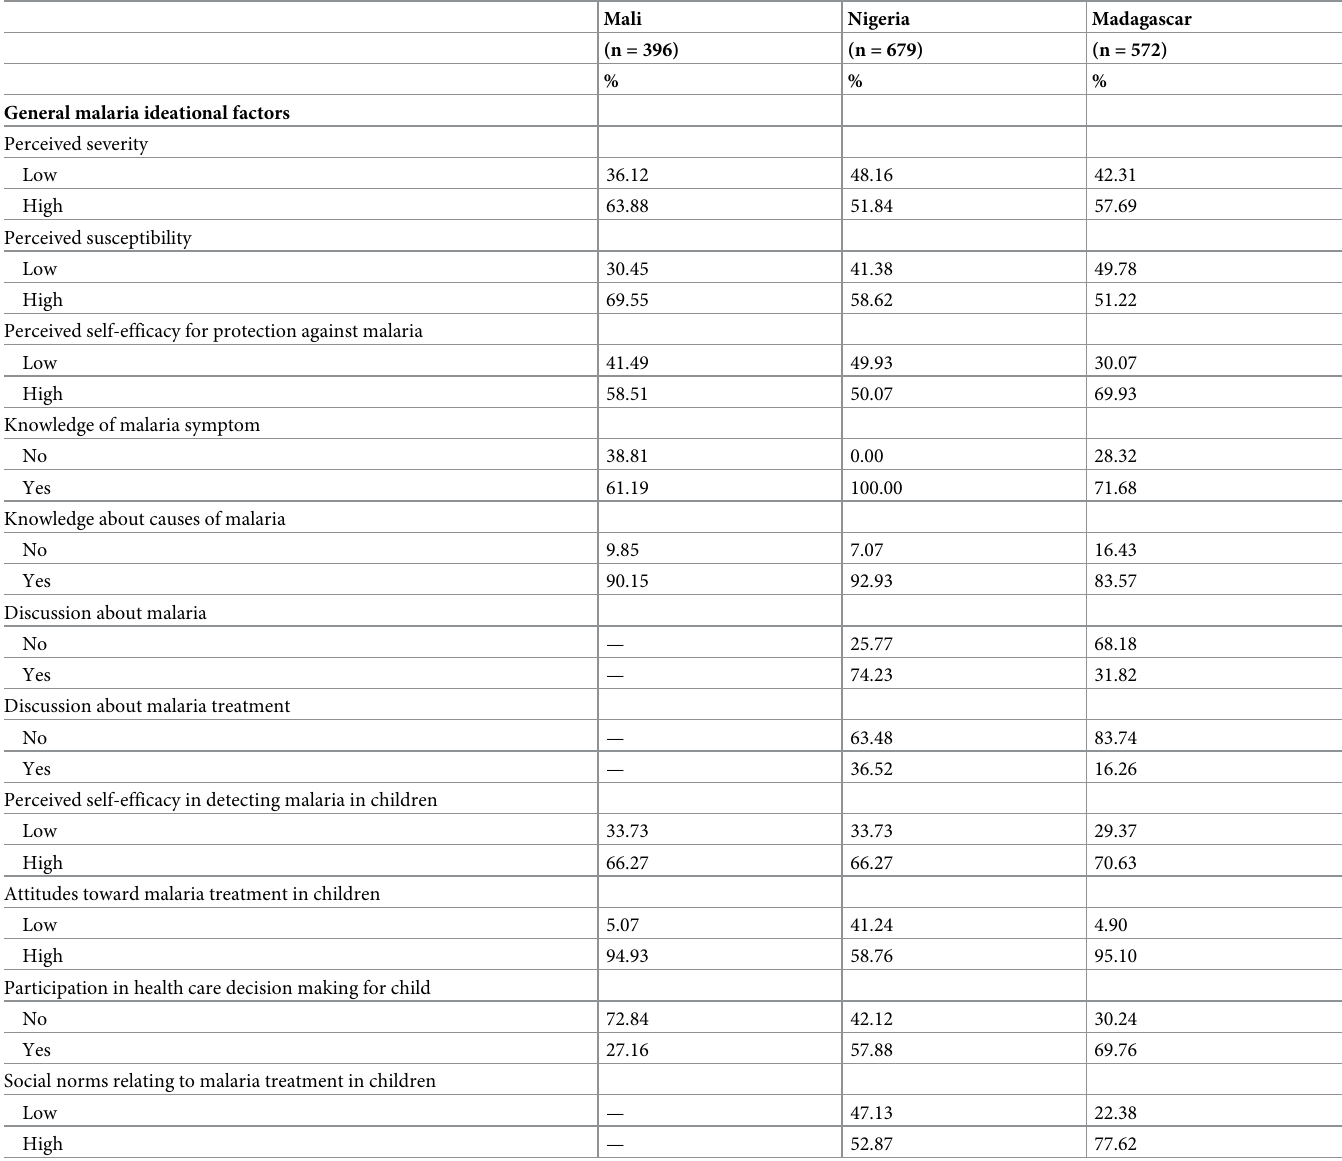
Table 2. Ideational factors related to malaria and malaria treatment among children under